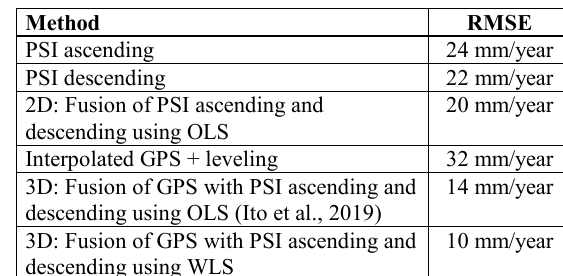
Figure 6. Interpolated results from GPS data: (a) east– west, (b) north–south, and (c) vertical displacement component. The velocity is shown in